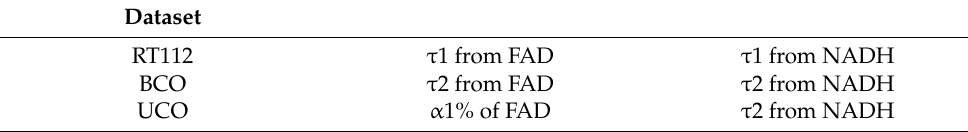
Table 4. FLIM parameters selected using a feature importance